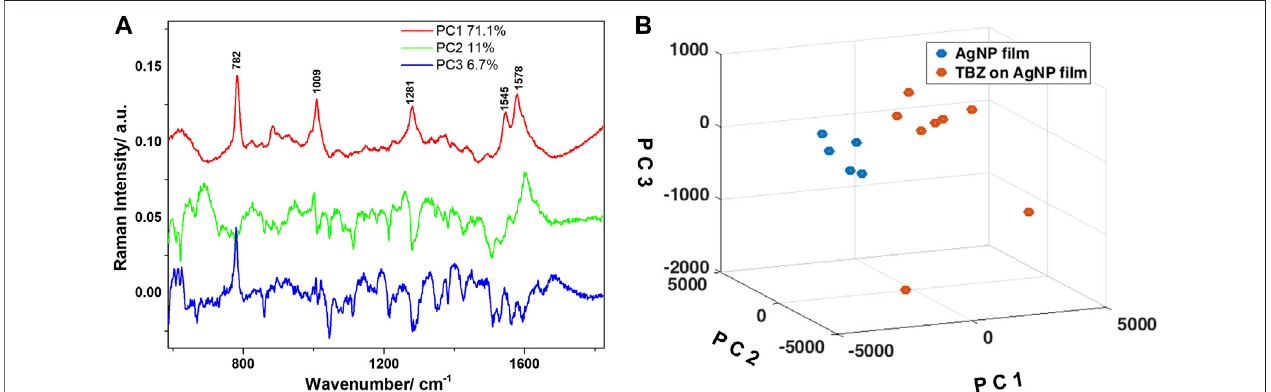
FIGURE 7 | (A) Loadings of the fi rst three principal components obtained after PCA applied in the 600 – 1800 cm − 1 spectral region. Legend shows the variance captured byeach principalcomponent. (B) Three-dimensional scatter plot showing the clustering ofthe spectra collected from the twoAg NPs fi lms as afunction ofthe scores of the fi rst three principal components.